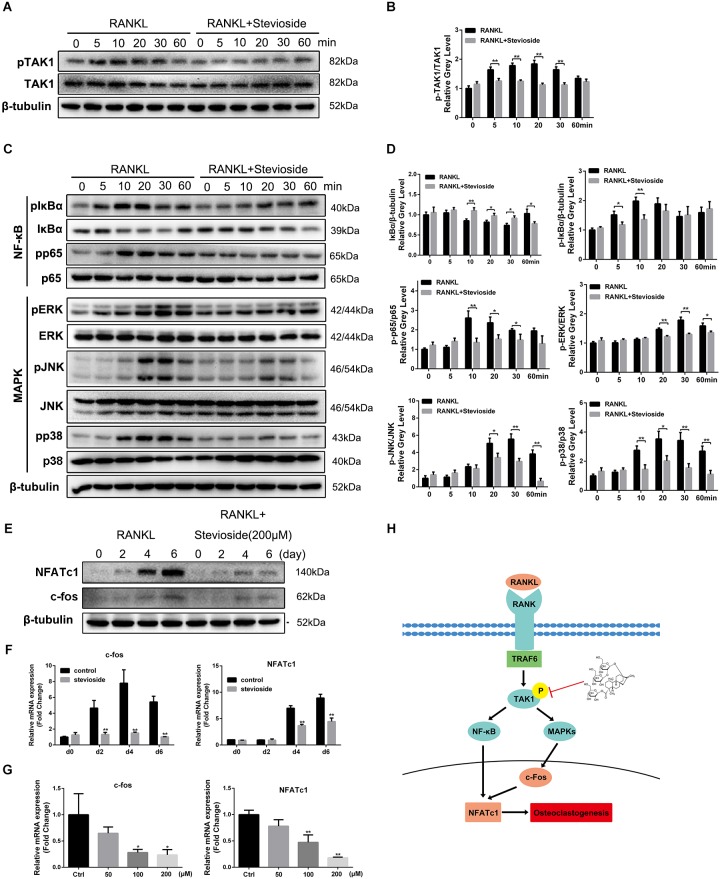
Stevioside inhibits osteoclast differentiation by specifically impairing RANKL-induced phosphorylation of TAK1 and subsequent activation of NF-κB/MAPK signaling pathways. (A,C) BMMs were pretreated with or without 200 μM stevioside for 4 h and then treated with 50 ng⋅mL-1 RANKL for the indicated periods. Cell lysates were analyzed using western blotting. (B) The gray level of phosphorylated TAK1 was normalized relative to total TAK1. (D) The gray levels of phosphorylated p65, ERK, JNK, and p38 were quantified and normalized relative to total p65, ERK, JNK, and p38. The gray levels of phosphorylated IκBα and IκBα were normalized to β-tubulin. (E) The protein expression levels of NFATc1 and c-Fos in BMMs treated with stevioside for 0, 2, 4, or 6 days. (F,G) The mRNA expression levels of NFATc1 and c-Fos in BMMs treated with the indicated stevioside concentrations for 0, 2, 4, or 6 days. RNA expression levels were normalized relative to the expression of GAPDH. (H) Schematic representation of the experiments presented in this figure. Data are presented as mean ± SD. ∗P < 0.05, ∗∗P < 0.01, compared with RANKL alone.